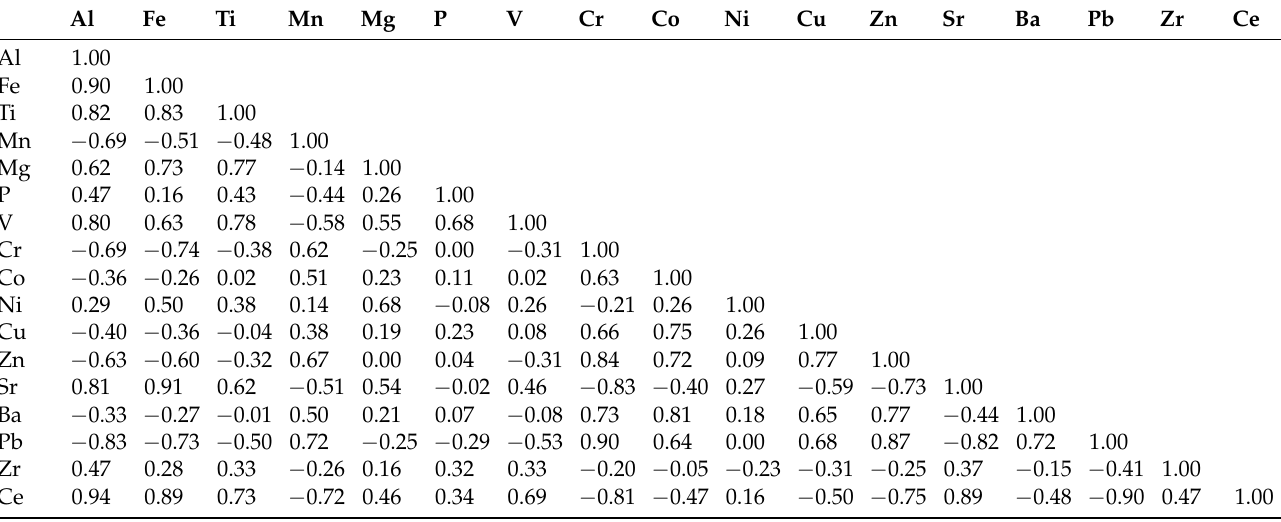
Table 9. Pearson’s correlation matrix of PTEs in surface sediments of